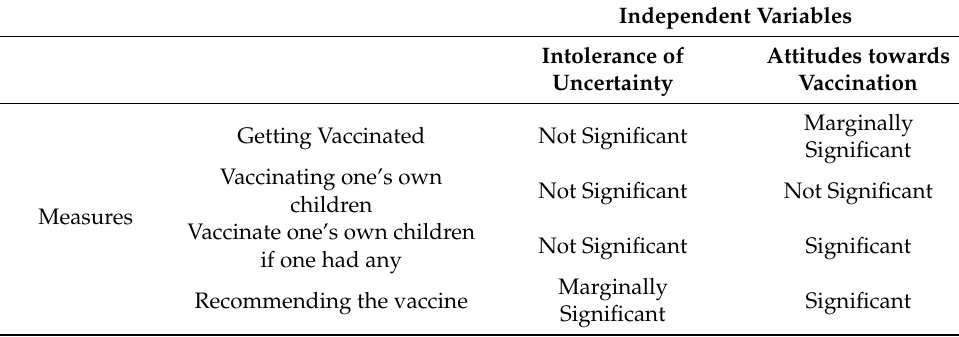
Table 5. Summary of repeated measures ANOVAs